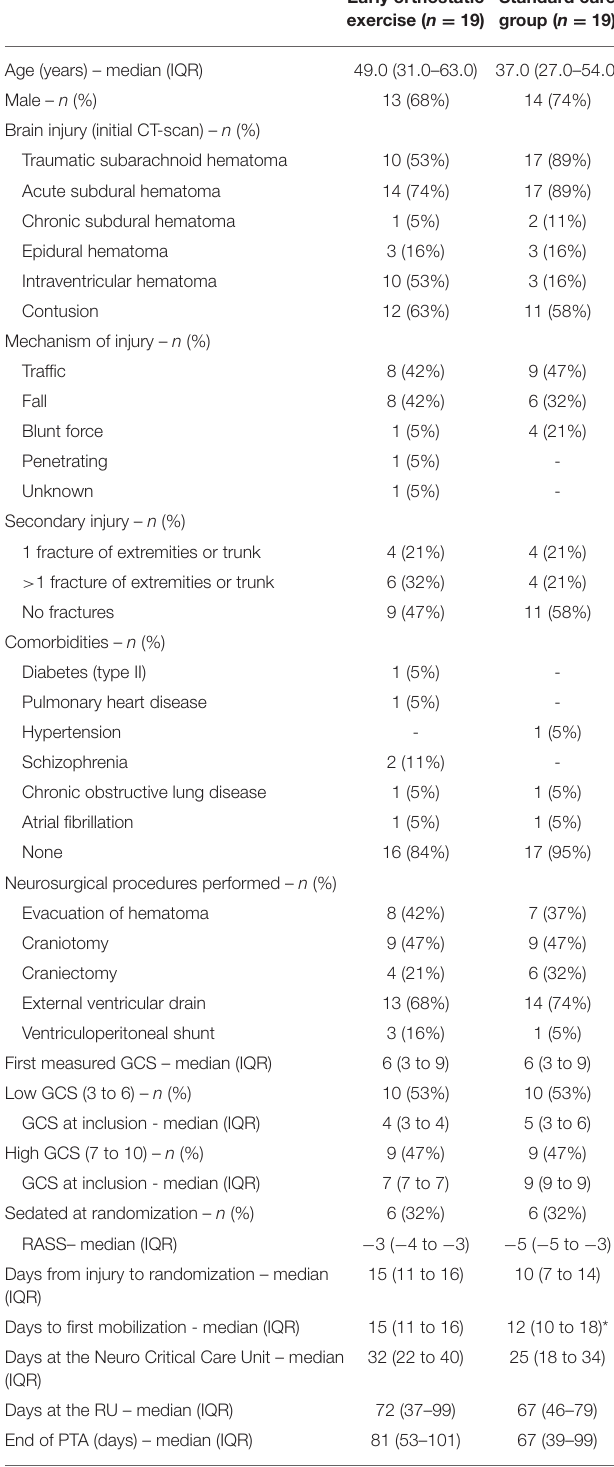
TABLE 1 | Baseline characteristics of included